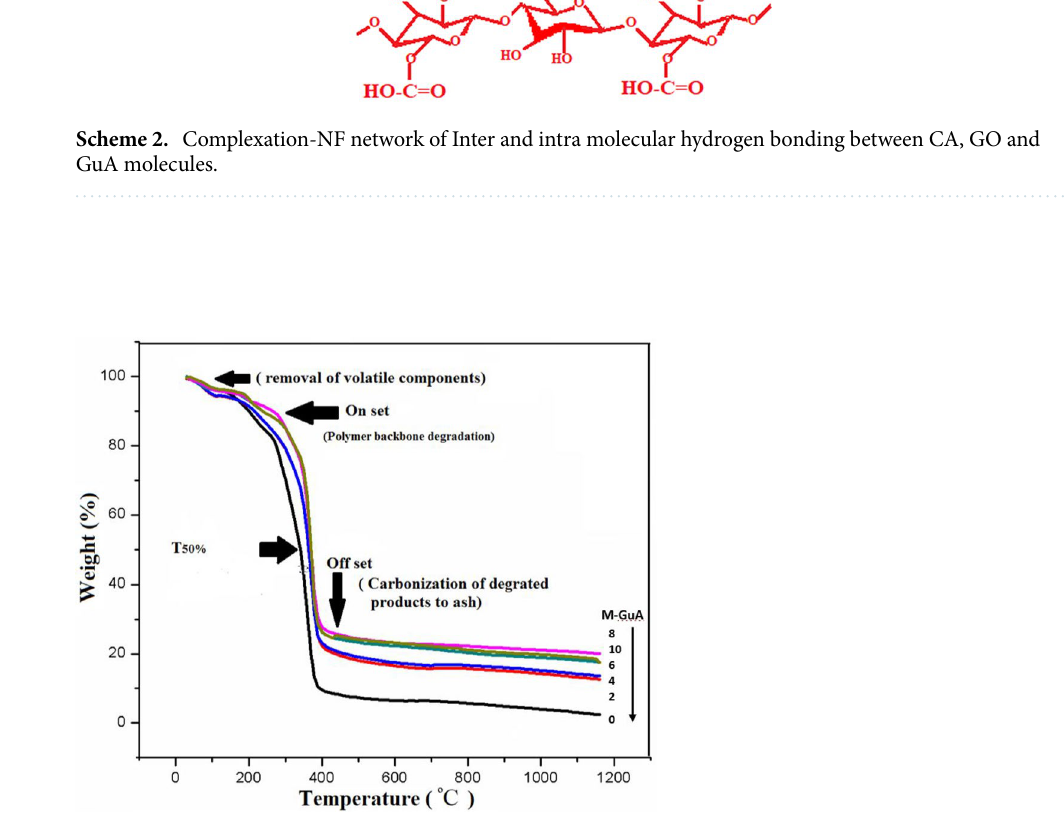
Figure 2. TGA of M-GuA membranes at various percentage weight loss. The number on the bottom right denoted the sample code, which are M-GuA8, 10, 6, 4, 2, 0, respectively from top to